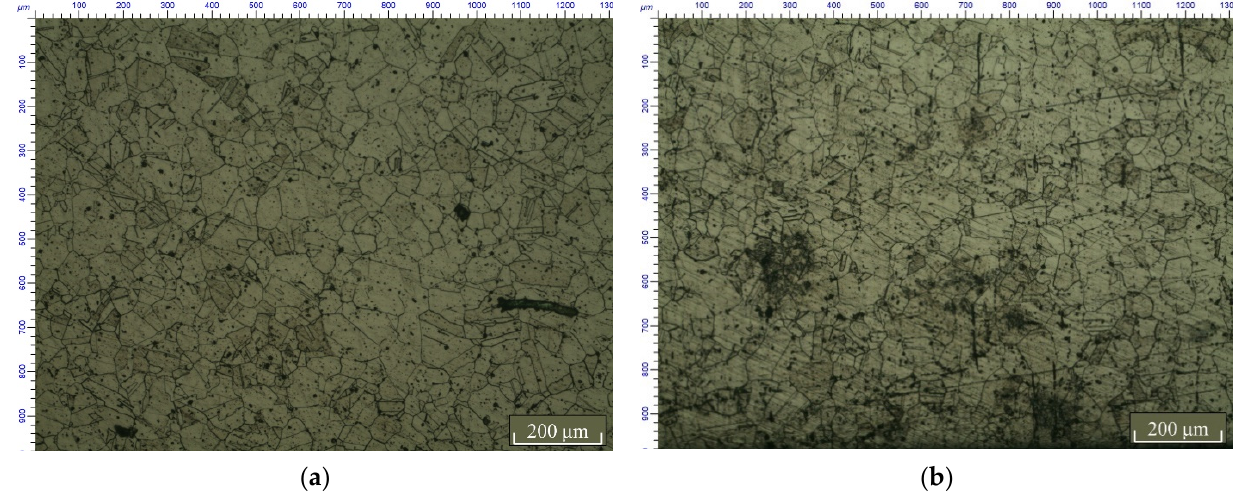
Figure 1. Billet’s microstructure 5 mm from the surface in the plane perpendicular to the rolling axis ( a ) and in the plane parallel to the rolling axis ( b ).